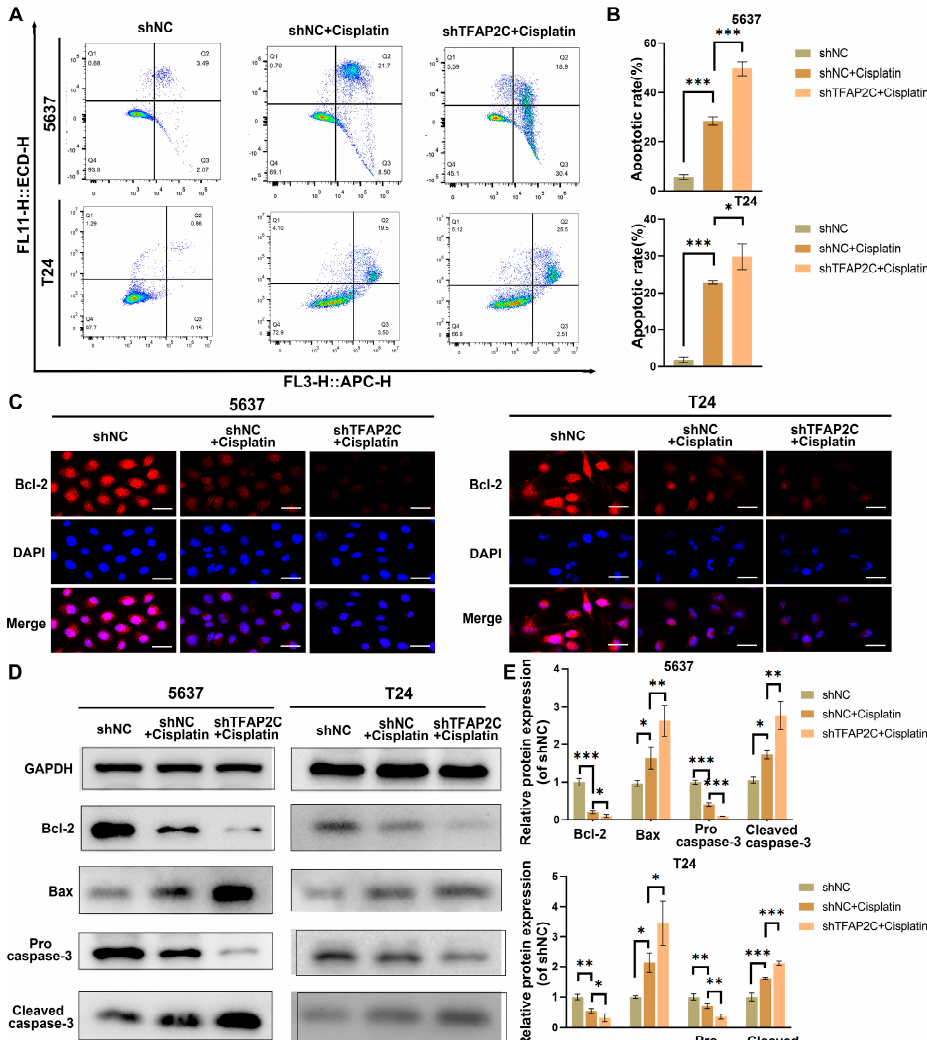
Figure 4. TFAP2C knockdown enhances cisplatin-induced apoptosis. ( A , B ) Flow cytometry